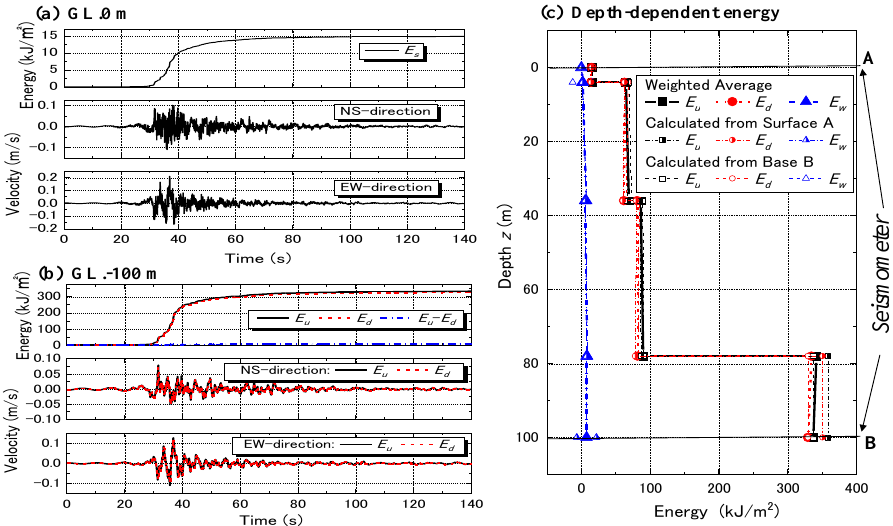
Figure 11. Calculation of wave energies in KiK-net Taiki: time–histories of energy and velocity at GL. 0 m ( a ) and at GL. −100 m ( b ) and depth-dependent cumulative energies E u , E d and E w ( c ). In Figure 11c, the energy flows along the depth calculated either from record A at surface or from record B at base are plotted with different symbols. The thick lines with close symbols are the average of the two calculations with the weight of the relative proximity to levels A and B. The two energy flows calculated from A and B are similar to each